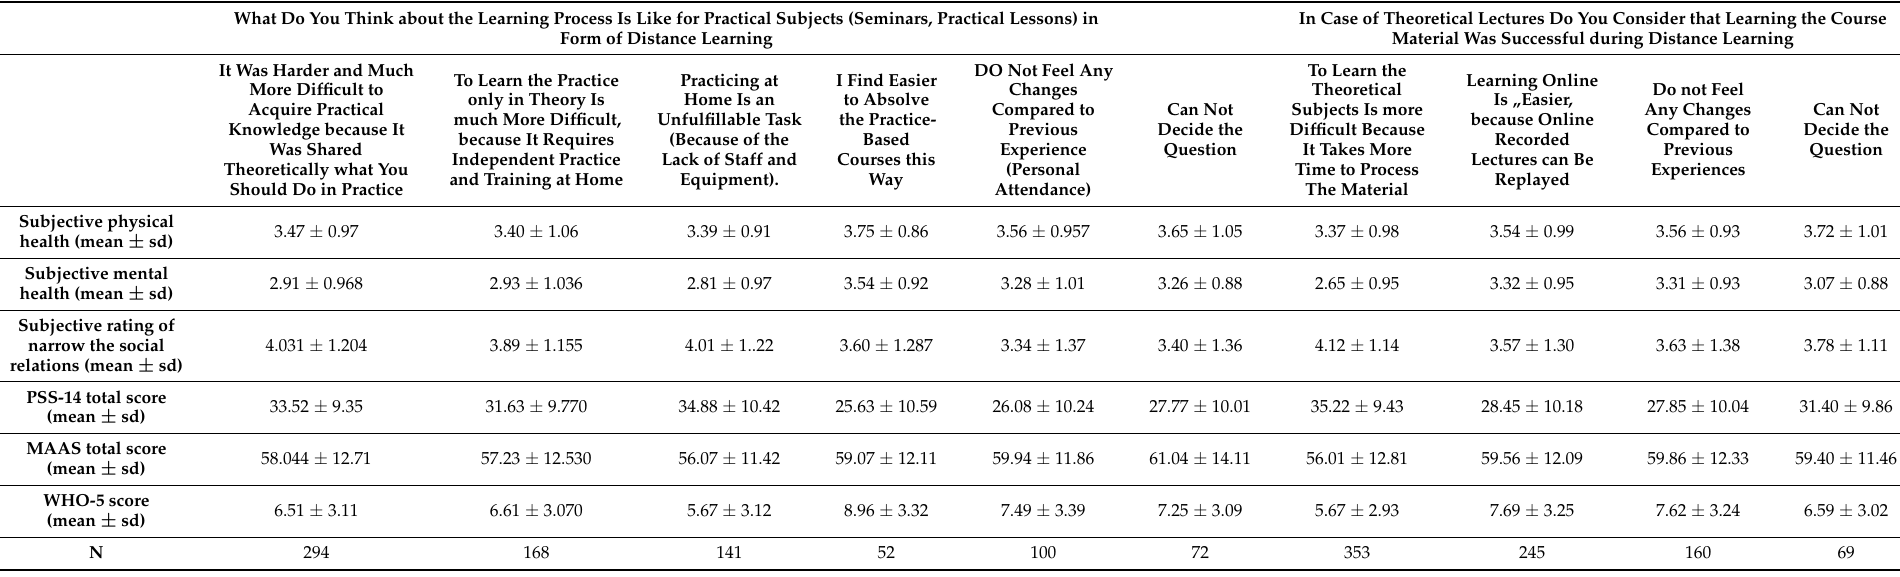
Table 2. Mean values and standard deviation of MAAS, PSS-14, WHO-5 total score, subjective physical and mental health, and subjective rating of narrowing of the social relationships regarding absolving of theoretical and practical lessons during the distance